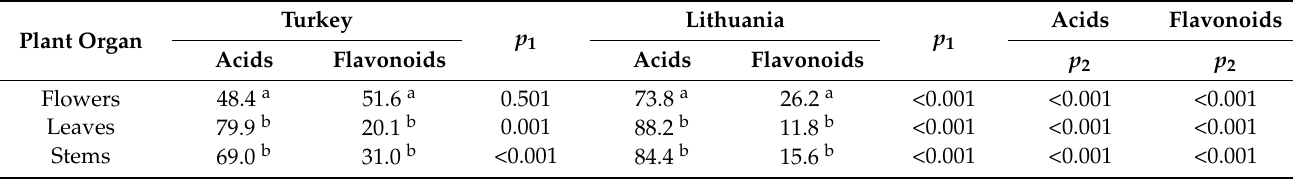
Table 2. Mean ratio (%) of total phenolic acids and flavonoids in plant organs of Achillea millefolium from Turkish and Lithuanian populations. Significant differences ( p 1 ) between compound groups according to the Wilcoxon matched pairs test and differences ( p 2 ) between countries according to Kruskal–Wallis test.